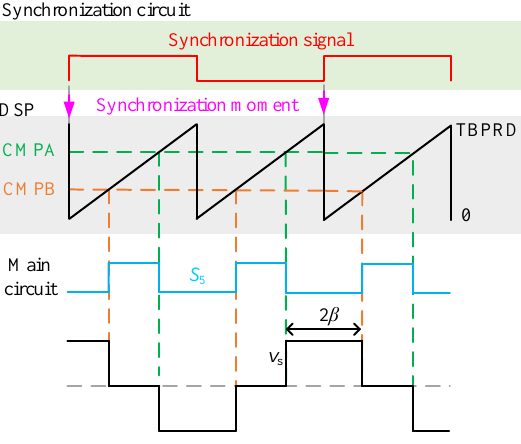
Figure 5. Typical synchronization waveforms.